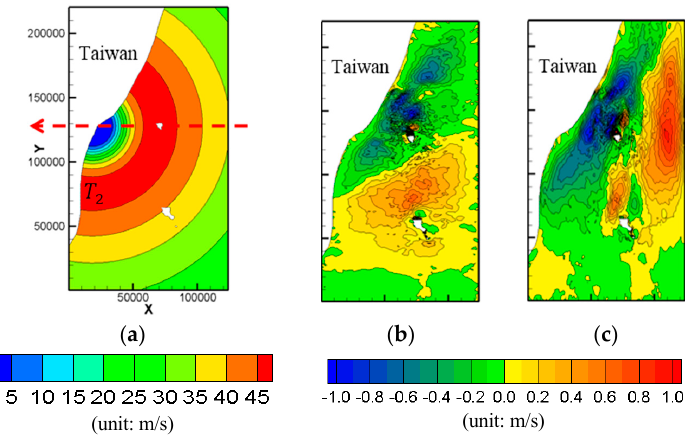
Figure 13. Contours of (a) W 10 , “net” (b) u -, and (c) v -contours (unit: m/s) of EW typhoon with moving speed W T = 2.5 m/s at three time instances T 0 – T 2 indicated by the three vertical lines of Figure 16a.